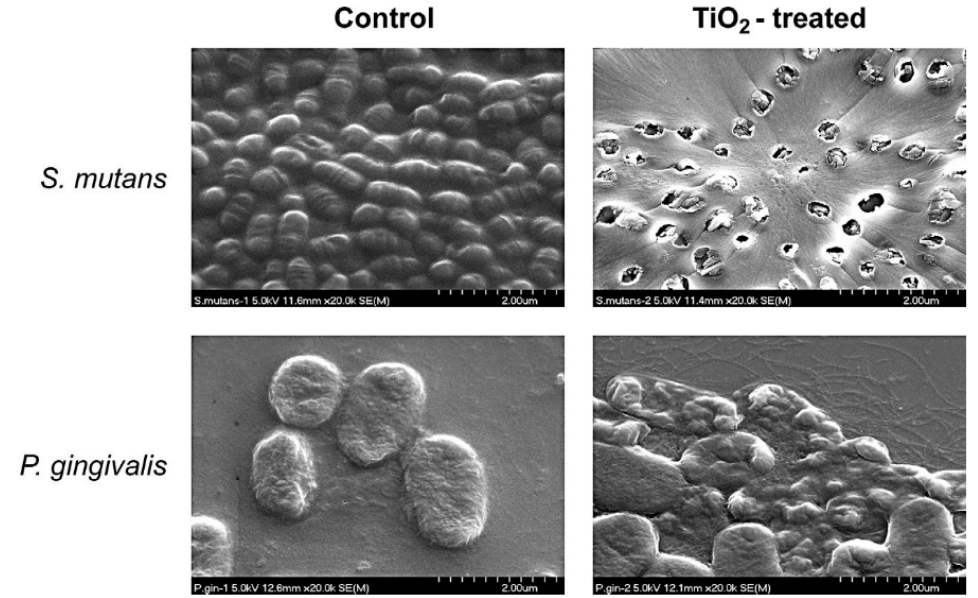
Figure 5. Scanning electron microscopy analysis of Streptococcus mutans and Porphyromonas gingivalis [11]. Cao et al. [69] performed a study of assessing antimicrobial adhesive properties of a thin film of nitrogen-doped TiO 2